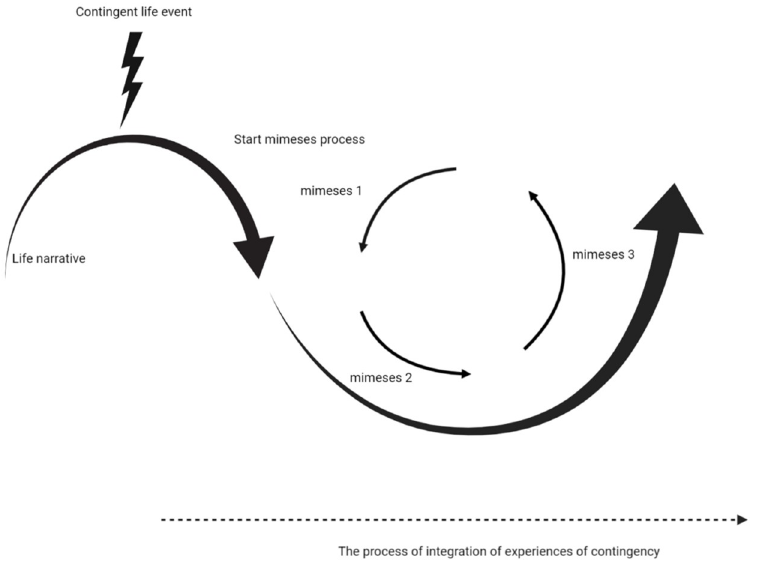
Fig 1. The relation between contingency, life narratives, mimesis and integration of experiences of contingency. After a contingent life event, which might result in an existential crisis, a process of integration of experiences of contingency starts to facilitate restoration of coherence and integration of this experience into the life narrative. The arrows indicate respectively a decrease and subsequent increase of coherence of the life narrative. This process has similarities with the mimesis process which describes the phases of development of a narrative concerning a specific experience, which as the cycle represents, is an iterative process where one can move through several mimesis cycles to process the experience of contingency until the experience feels sufficiently integrated into one’s life narrative.